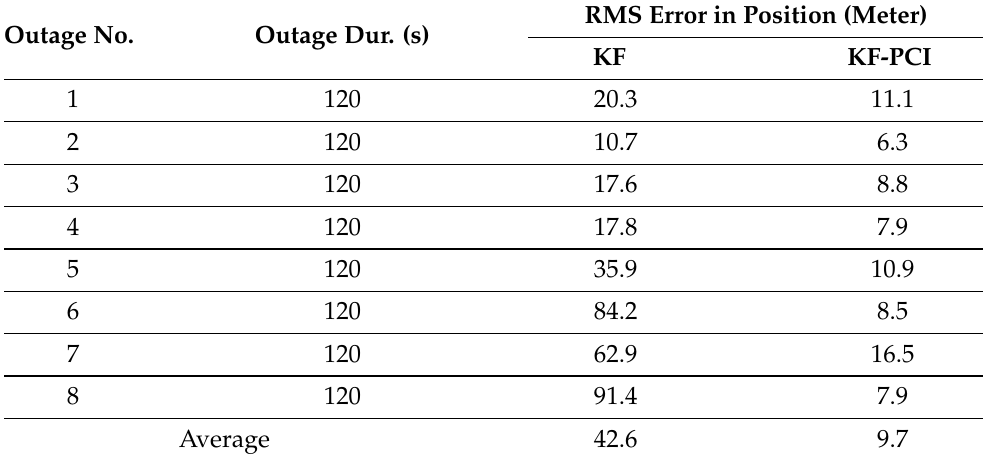
Table 2. Two-dimensional position rms-error comparison.